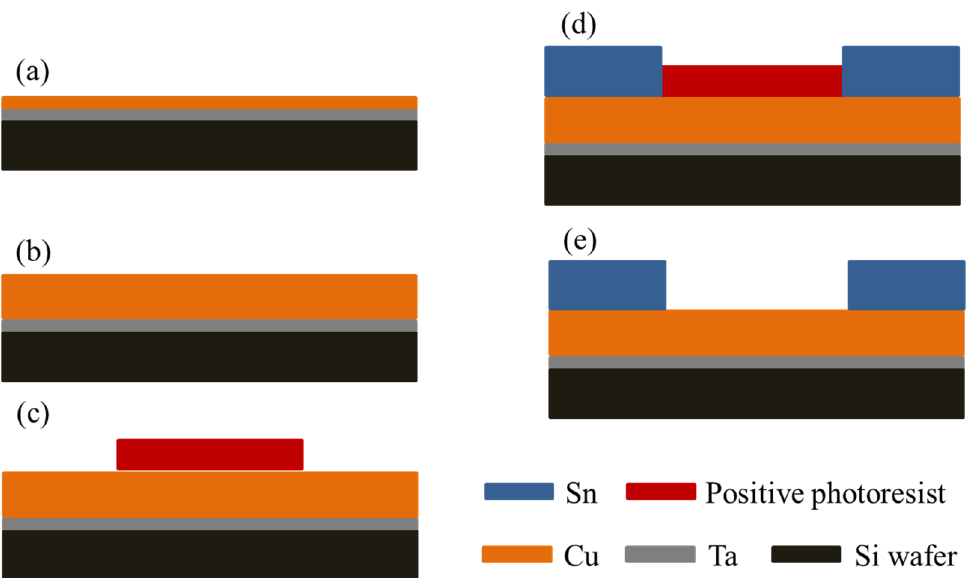
Figure 1. The sample production process consisting of five major steps: ( a ) high-power impulse magnetron sputtering (HiPIMS) and DC power were used to sputter the sample with 250 nm Ta and 550 nm Cu films, respectively; ( b ) while in the plating solution, a 20 μm Cu film was electroplated onto the sample; ( c ) the samples were patterned with a positive photoresist; ( d ) a 20 μm Sn film was electroplated on the sample; and ( e ) the positive photoresist was removed. Table 1. Conditions for electroplating tin and copper